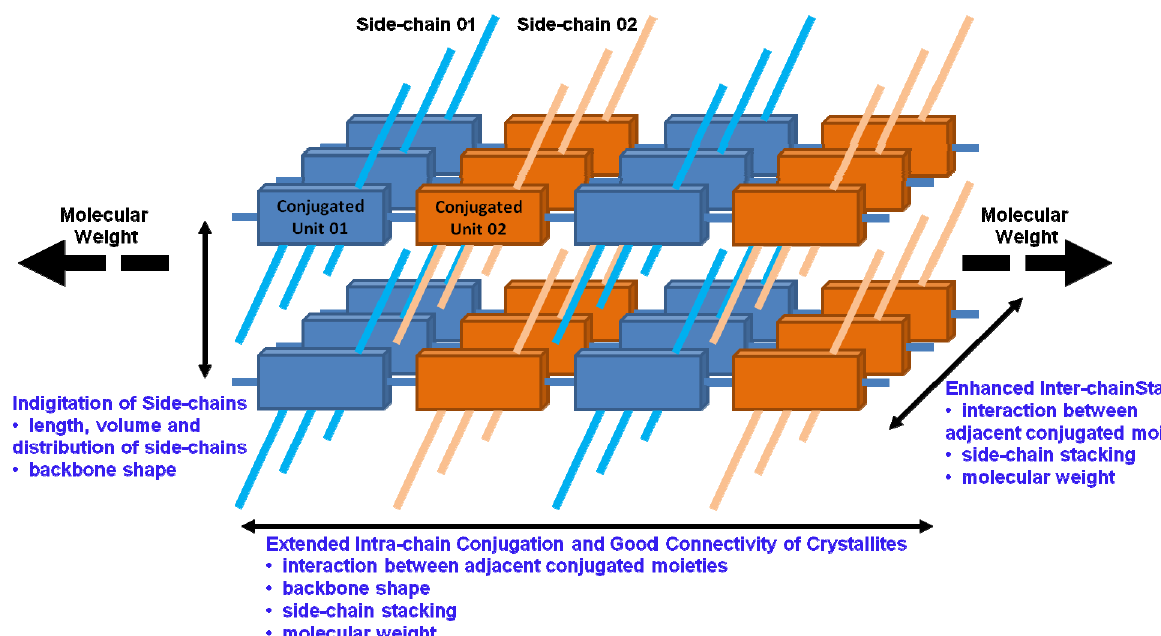
Figure 15. Schematic illustration of the structural factors influencing the aggregation of charge transport property of conjugated